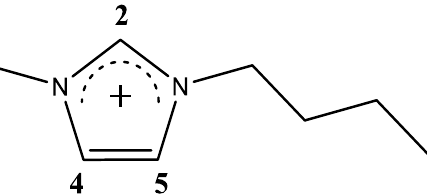
Figure 1. Structural formula of the 1-butyl-3-methylimidazolium cation, [C 4 C 1 im] and atom numbering of the ring positions.